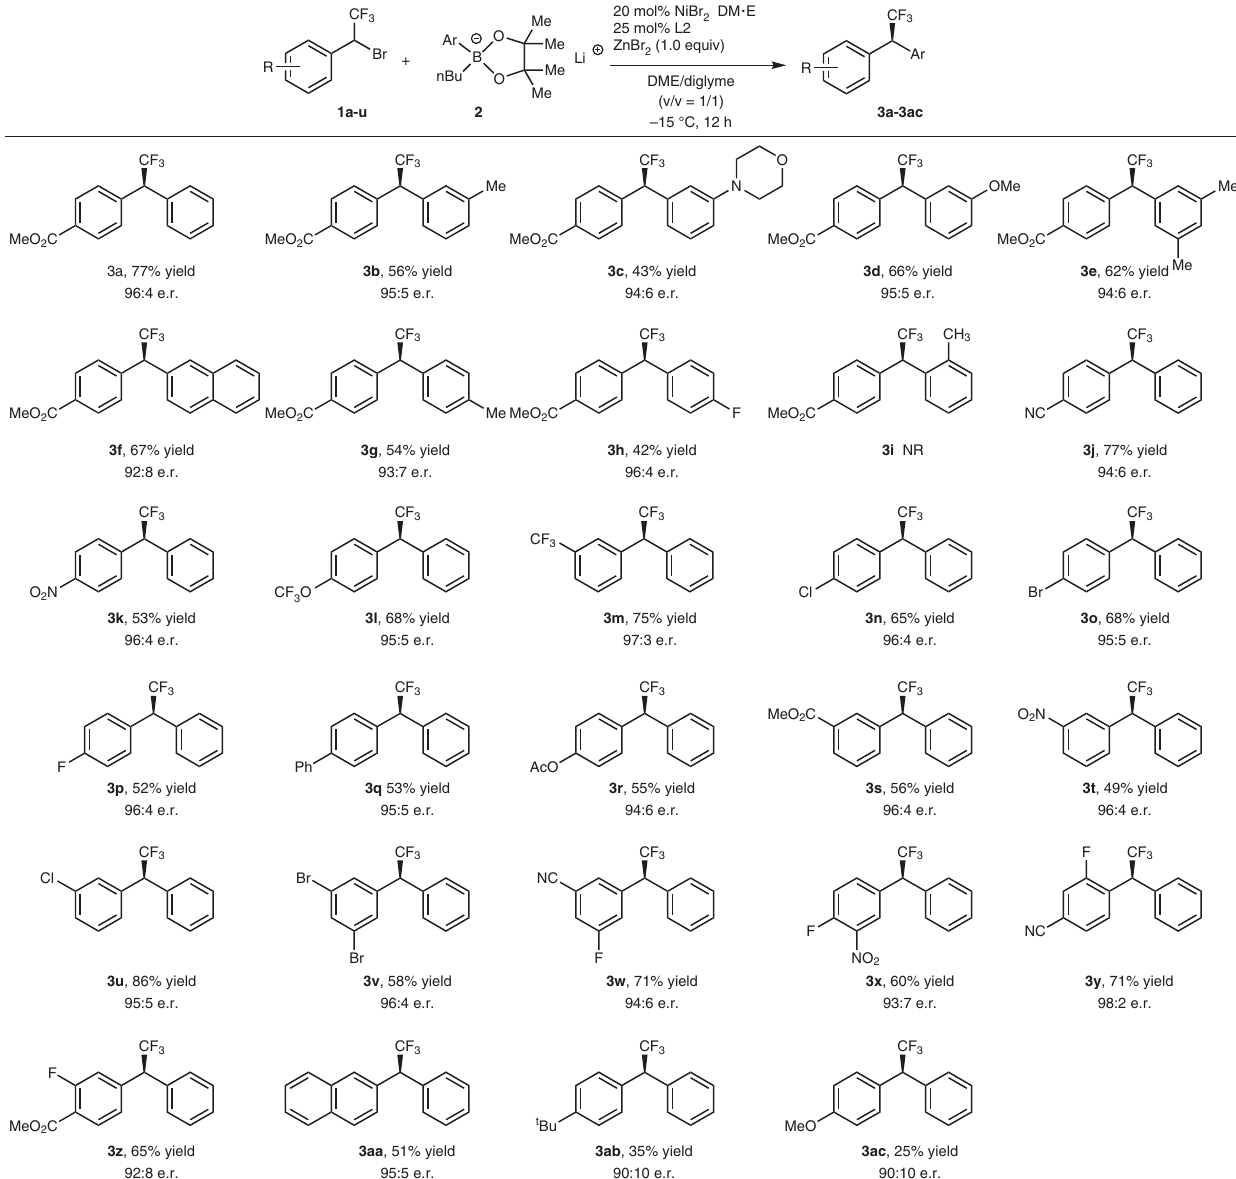
Fig. 5 Substrate scope of asymmetric coupling of α -bromobenzyl tri fl uoromethane with lithium aryl boronates. All reaction were conducted with compound 1 (0.3 mmol), phenylboronic pinacol ester 2 (0.9 mmol), NiBr 2 (cid:129) DME (20 mol%), ligand L2 (25 mol%) and ZnBr 2 (0.3 mmol) in DME/diglyme ( v / v = 1/1) at − 15 °C for 12 h. Isolated yields and e.r. was determined by chiral HPLC